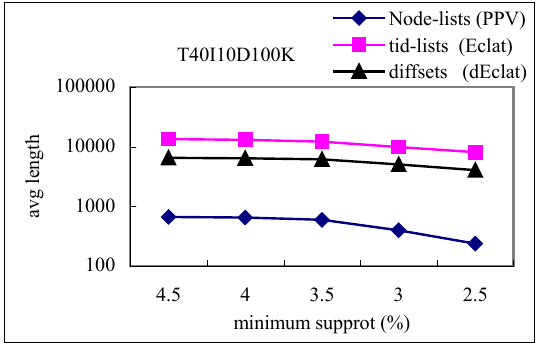
Fig. 8. Comparative Performance on Accidents